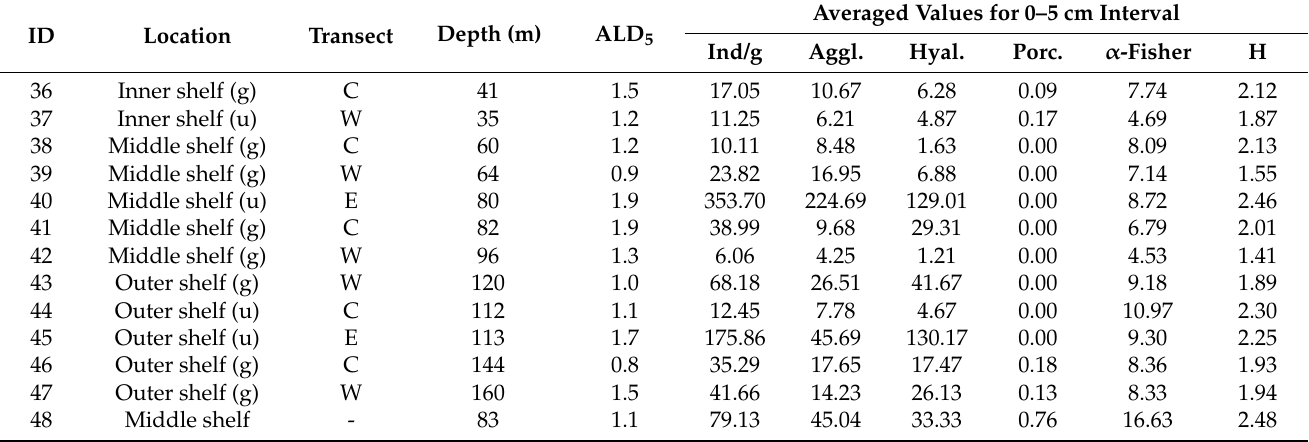
Table 3. Summary of data for living foraminifera in the analyzed samples. Average living depth (ALD 5 ) for the total fauna in the first 5 cm; (g) gullies; (u) seafloor undulations. The total number of specimens, proportion of agglutinated (Aggl.), hyaline (Hyal.) and porcelanaceous (Porc.) taxa (expressed as ind/g) and the diversity indices ( α -Fisher and H) are reported for each sample. (W) western transect, (C) central transect, (E) eastern